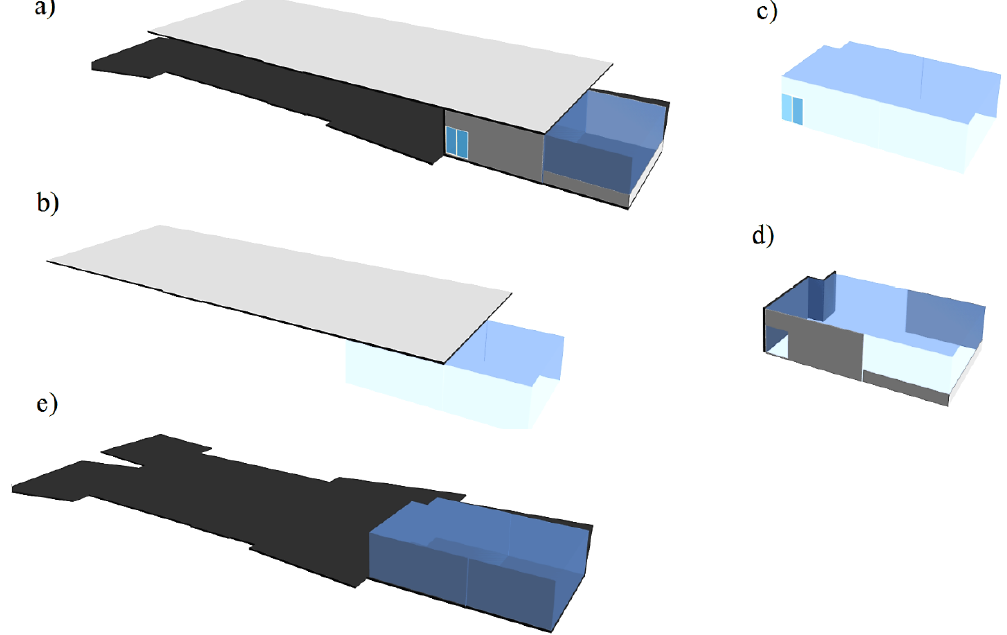
Figure 6. Query results for the building elements bounding the legal space of an apartment unit. ( a ) All building elements; ( b ) covering; ( c ) window; ( d ) walls; and ( e ) slab.